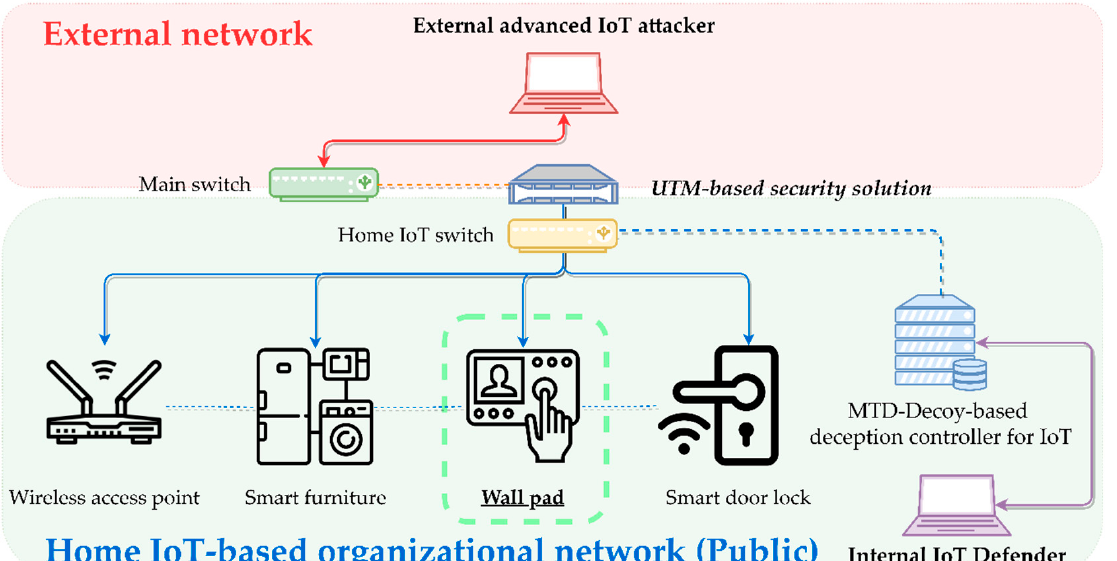
Figure 4. Overview of the home IoT-enabled topology with an organizational attack–defense strategy for Scenario 1.